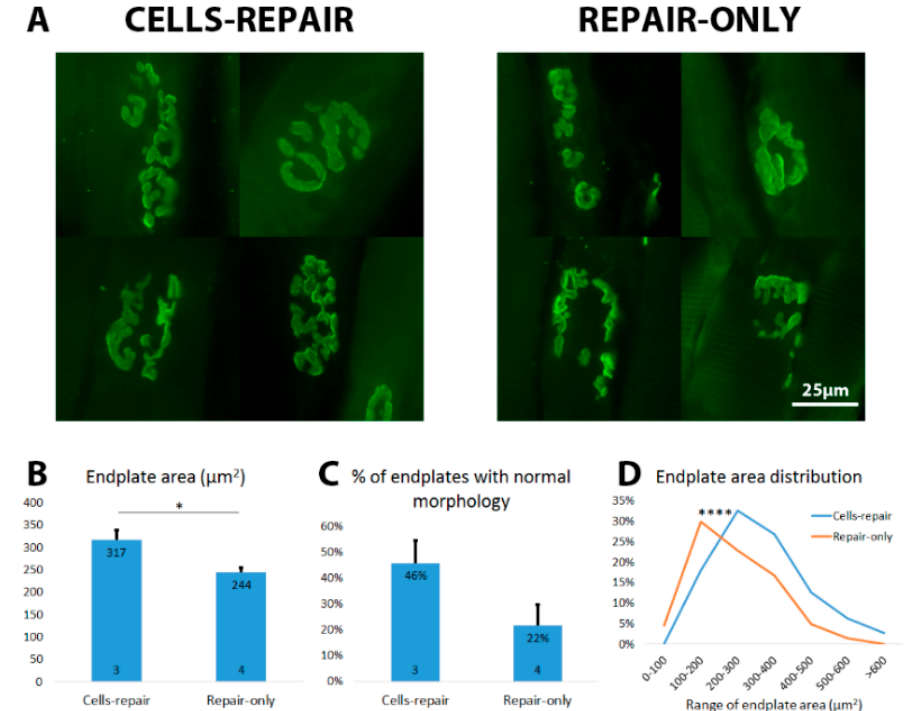
Figure 10. Cell transplantation together with a delayed nerve repair helped to preserve the muscle endplates compared to the repair-only group. ( A ) Typical muscle endplates stained with α -BTX from the both groups are shown; ( B ) The cells-repair group had significantly larger endplates compared to the repair-only group. * p < 0.05; ( C ) More endplates with normal pretzel-like morphology were seen in the cells-repair group. Data is shown as mean + SEM. The number of animals in both groups is shown inside the bar base. The number of animals in both groups is shown inside the bar base; ( D ) Distribution of the endplates was shifted to the higher range in the cells-repair group compared to the repair-only group. **** p < 0.0001.